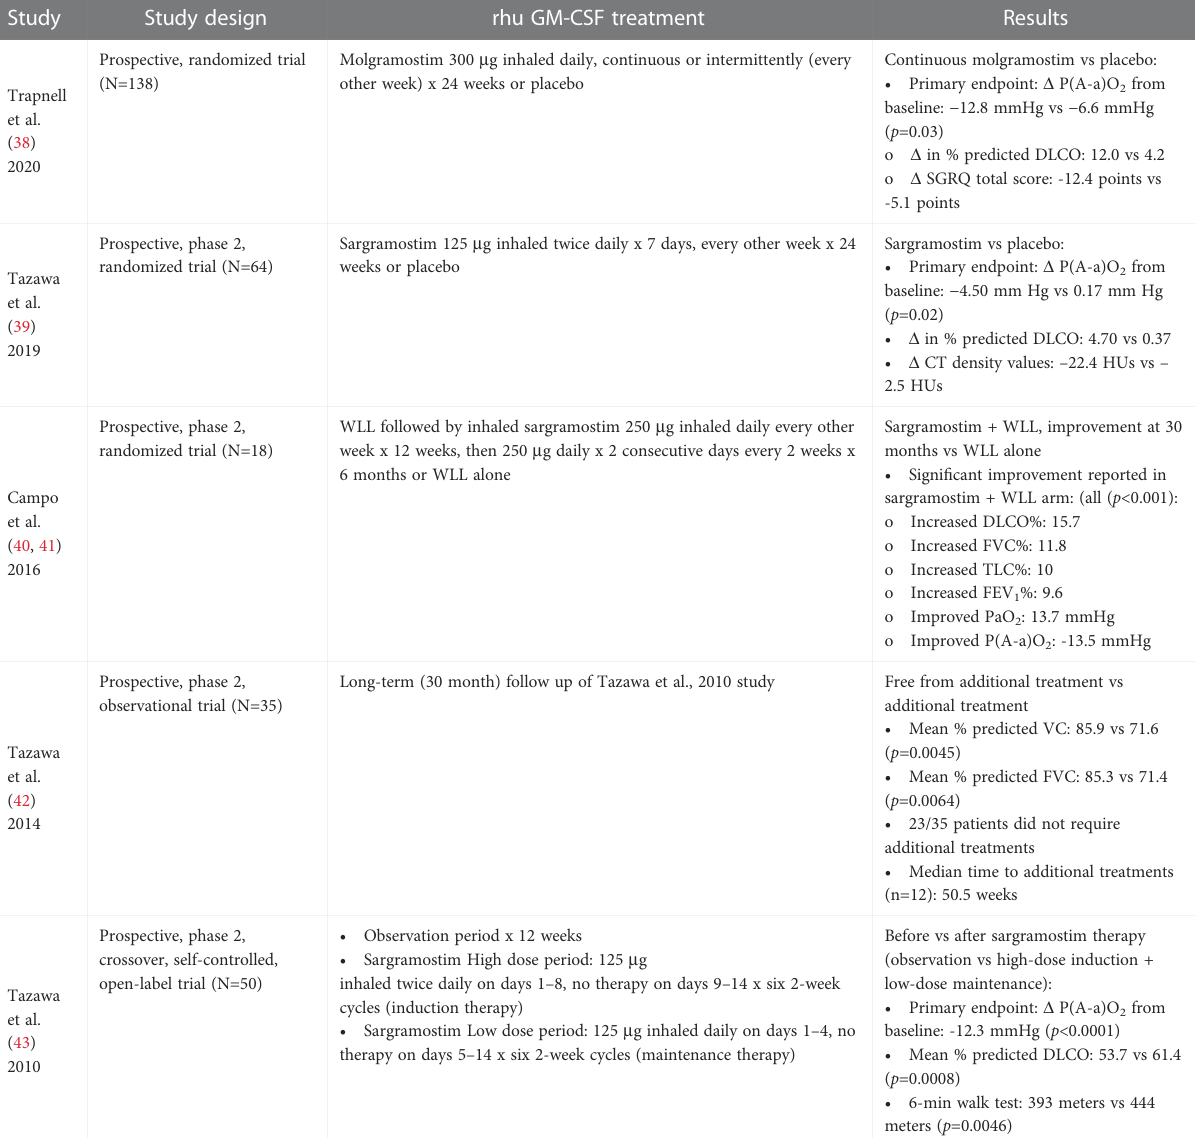
TABLE 2 Inhaled rhu GM-CSF phase 2-3 clinical studies in aPAP. Study Study